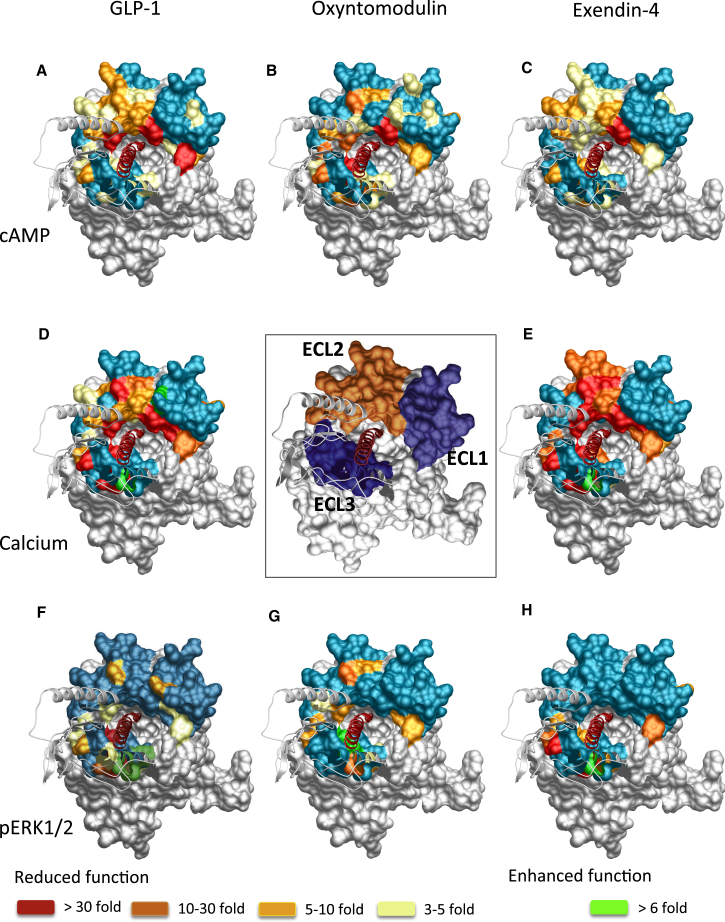
Heatmap 3D Representation of the GLP-1R Extracellular Face Based on Efficacy Data from Three Different Signaling AssaysMolecular model of the GLP-1R-GLP-1 complex showing the extracellular surface of the TM bundle. All residues assessed in this study are shown in the center box; the locations of residues in ECL1, ECL2, and ECL3 are highlighted in purple, orange, and blue, respectively. Residues that when mutated altered efficacy are highlighted in (A)–(H). (A–C) cAMP efficacy of GLP-1 (A), oxyntomodulin (B), and exendin-4 (C); (D and E) Ca2+ efficacy of GLP-1 (D) and exendin-4 (E); (F–H) pERK1/2 efficacy of GLP-1 (F), oxyntomodulin (G), and pERK1/2 (H). Teal indicates residues that were assessed and did not alter efficacy; yellow (3- to 5-fold), pale orange (5- to 10-fold), orange (10- to 30-fold), and red (>30-fold) are residues that statistically altered efficacy. The 3D heatmaps can be found in Active model S1 (Data S1).